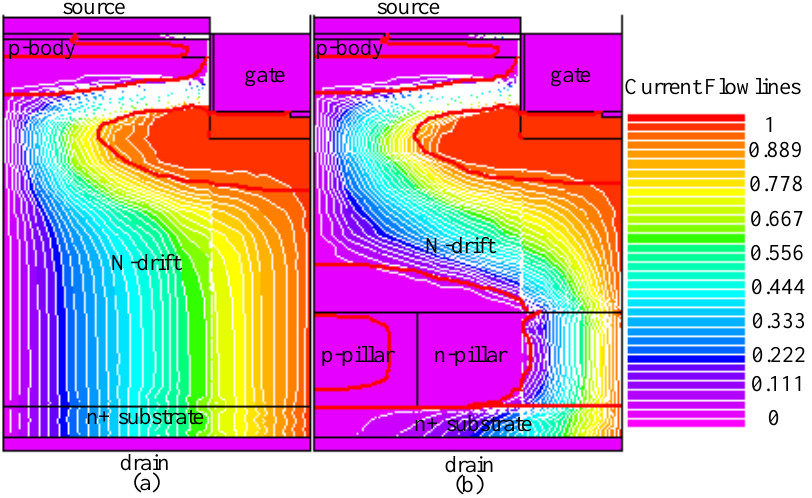
Figure 4. Distributions of current flowlines at J ds = 100 A/cm 2 in ( a ) C-UMOS and ( b )